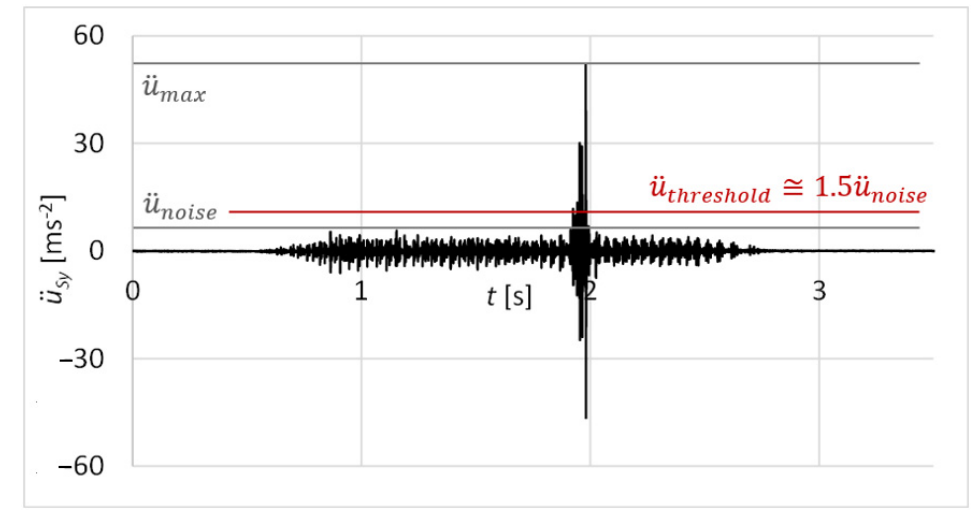
Figure 26. Threshold value of vibration acceleration.